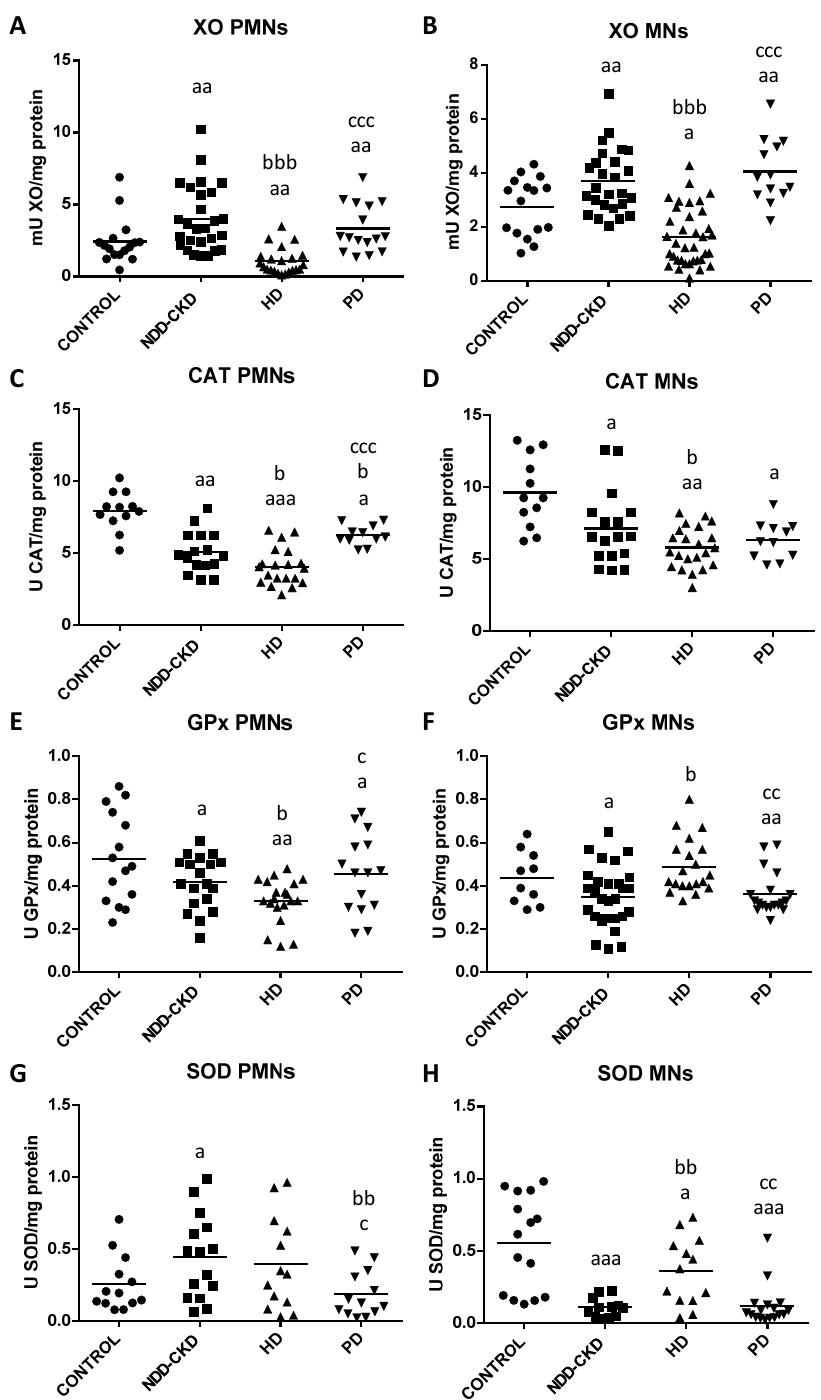
Figure 2. Oxidative stress parameters in isolated peripheral blood polymorphonuclear (PMNs) and mononuclear (MNs) leukocytes from healthy subjects (control), non-dialysis-dependent chronic kidney disease (NDD-CKD), hemodialysis (HD) and peritoneal dialysis (PD) patients. ( A ) PMNs and ( B ) MNs xanthine oxidase activity (XO; mU/mg protein); ( C ) PMNs and ( D ) MNs catalase activity (CAT; U/mg protein); ( E ) PMNs and ( F ) MNs glutathione peroxidase activity (GPx; U/mg protein); ( G ) PMNs and ( H ) MNs superoxide dismutase activity (SOD; U/mg protein). Data are shown as the mean (horizontal bar) of 10–32 values corresponding to the number of subjects analyzed in each group. Each value is the mean of duplicate assays. a p < 0.05, aa p < 0.01 and aaa p < 0.001 versus control; b p < 0.05, bb p < 0.01 and bbb p < 0.001 versus NDD-CKD patients; c p < 0.05, cc p < 0.01 and ccc p < 0.001 versus HD patients.